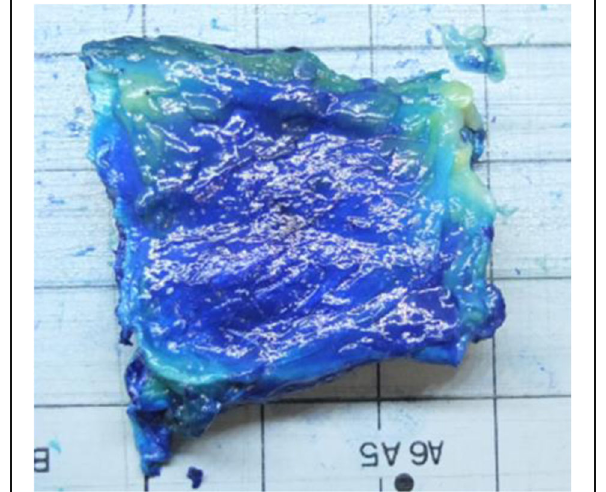
Fig. 3 Common Extensor Tendon (CET) held in wax surround of bench microtome. The four areas of algorithmically derived colour intensity are seen within each of the four contour